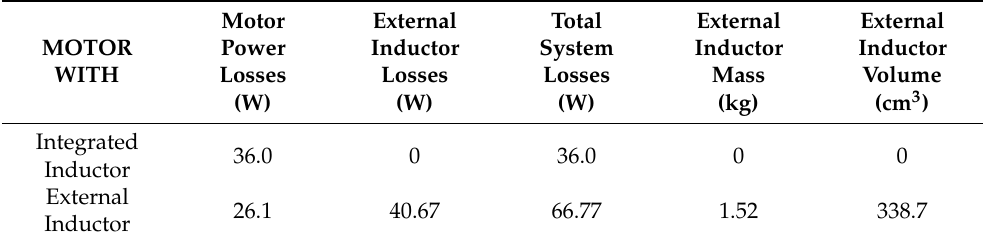
Table 1. Power Losses of Motor with Integrated and External